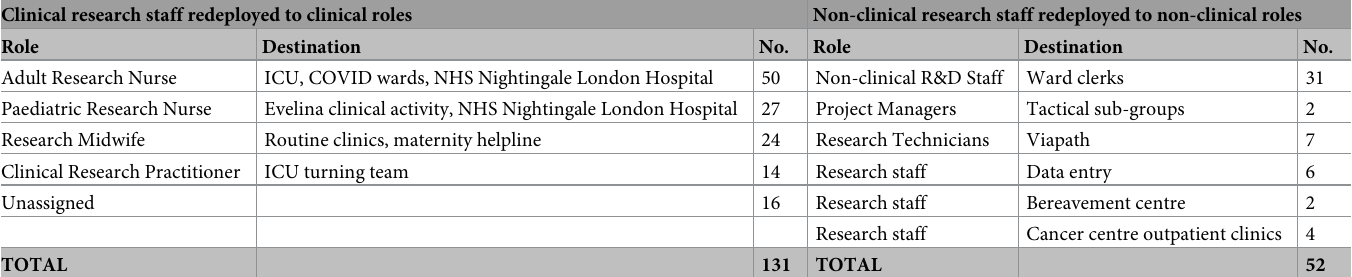
Table 4. Clinical and non-clinical research staff redeployment on 14 th April 2020. Clinical research staff redeployed to clinical